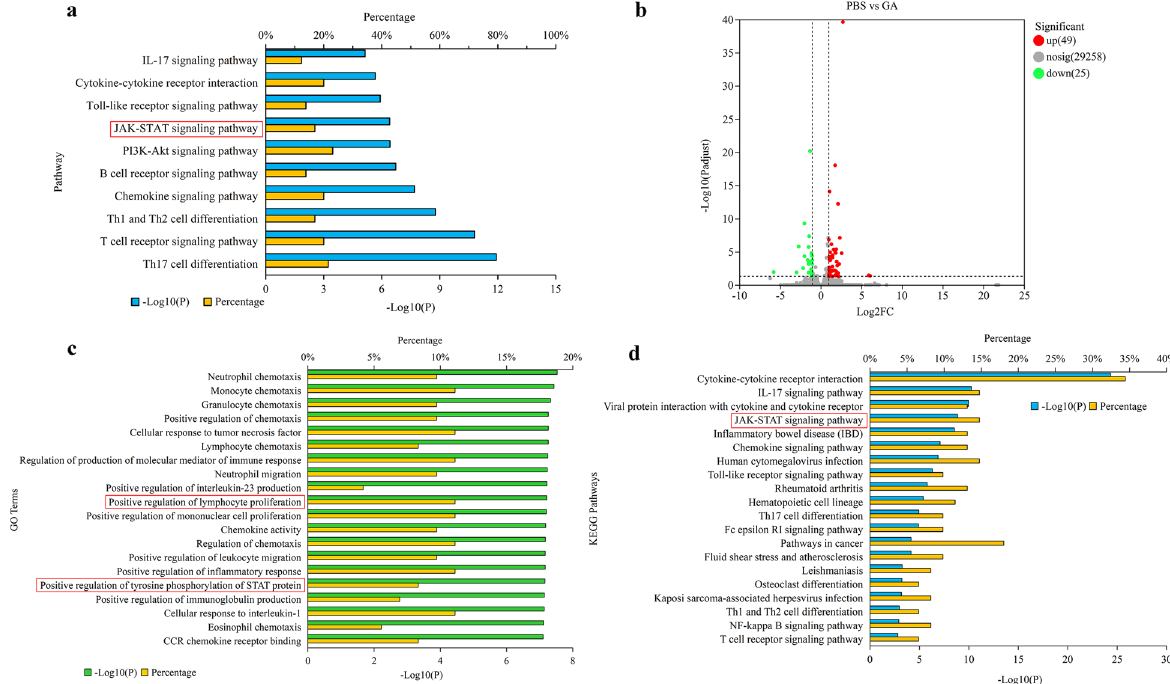
Fig. 4 The action mechanism of GA on CAR-T. a Pathway enrichment analysis of key hubs from network pharmacology analysis. b The volcano plot of DEGs from RNA-seq analysis (GA:100 μM; n 3). c The top 20 significantly enriched GO terms by RNA-seq analysis. d The top 20 significantly = enriched KEGG pathways by RNA-seq analysis. ( a c d ) The ordinate stands for the main pathways, the primary abscissa stands for minus log 10( P ), and the secondary abscissa stands for the percentage of key hubs or DEGs involved in the corresponding main pathways out of total key hubs or